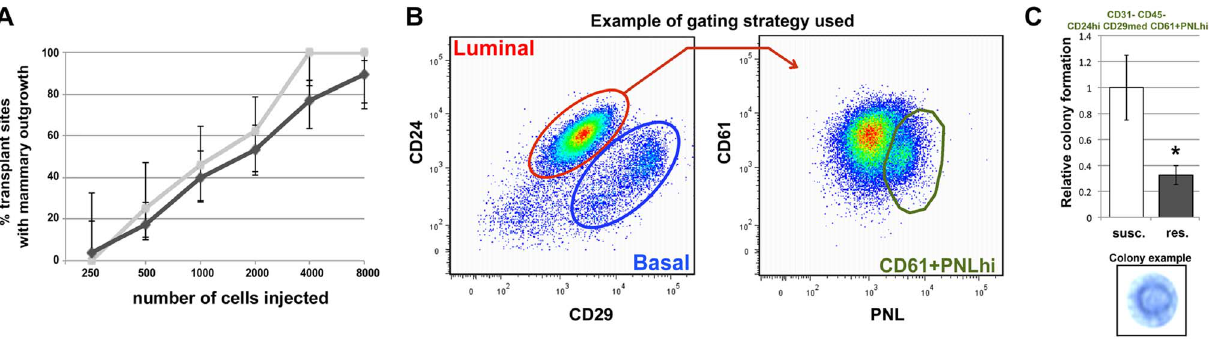
Figure 4. Mcs1a affects rat mammary epithelial cell (RMEC) growth and differentiation. A) Results of the limiting-dilution RMEC transplantation assay. Graphed is the percentage of transplant sites with an outgrowth versus the number of RMECs transplanted. Vertical bars represent lower and upper limits of a 95%-confidence interval for a proportion. Outgrowth potential of RMECs from the susceptible congenic control (susc.; light grey) and Mcs1a resistant congenic (res.; dark grey) line (lines W4 and W5 combined) is not significantly different. B) Pseudocolor dot plots from a susceptible congenic control sample, representing the gating strategy used to enrich for clonogenic luminal RMECs using cell sorting on the BD FACS Aria. CD31–CD45 2 RMECs were divided into luminal and basal cells based on CD24 and CD29 expression (left panel). Based on staining with anti-CD61 and peanut lectin (PNL), the clonogenic luminal cell population (CD45–CD31-CD24hiCD29medCD61 + PNLhi; Figure S3) was selected for Matrigel assays (right panel). C) Graphed is the average ( + / 2 sem) number of spherical mammary colonies formed in Matrigel assays plating 10,000 clonogenic RMECs sorted from the susceptible congenic control (n=12) and Mcs1a resistant congenic line (n=10; line W4 only). In the lower panel, a representative picture of a spherical mammary colony in a methylene blue-stained Matrigel is shown. Significantly different colony-forming ability (P , 0.05) is indicated by an asterisk.